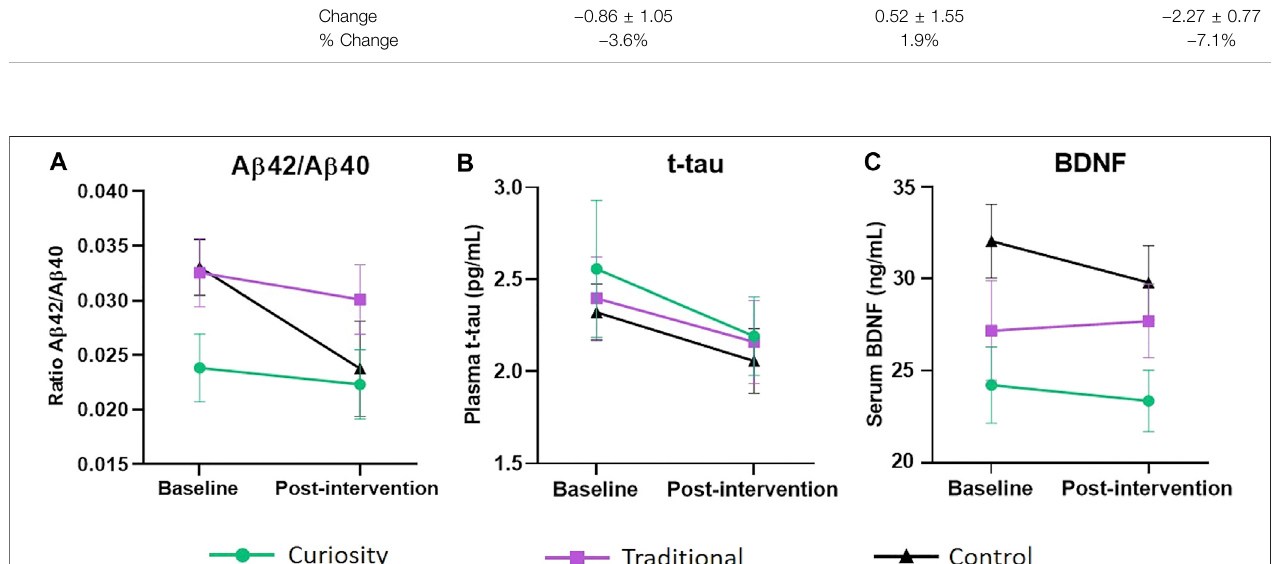
FIGURE 1 | Change in A β 42/A β 40 ratio, t-tau and BDNF levels from baseline to post-intervention. (A) Change in plasma A β 42/A β 40 ratio from baseline to post- interventioninthecuriositygroup(showningreen),traditionalgroup(showninpurple)andcontrolgroup(showninblack).Althoughthecontrolgroupexhibitedasteeper decline, an ANCOVA did not reveal any signi fi cant group difference. (B) Change in plasma t-tau levels (pg/ml) from baseline to post-intervention in the curiosity group, traditional group and control group. No signi fi cant group difference was found. (C) Change in serum BDNF levels (ng/ml) from baseline to post-intervention in the curiositygroup, traditional group andcontrol group.BDNF levels decreased signi fi cantlyinthecontrolgroup( p (cid:1) 0.01).However, therewere nosigni fi cantdifferences in BDNF concentration between the three intervention groups. All data were analyzed using ANCOVA with post-hoc Bonferroni adjustment. Data are represent as mean ±